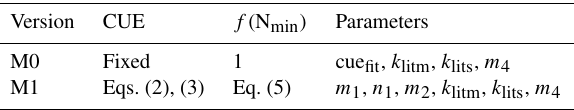
Table A3. List of parameters calibrated for two versions of the litter decomposition model (M0, M1): k litm and k lits are, respectively, the turnover rates of metabolic and structural litter pools, m 4 is the coefficient in Eq. (8), cue fit is the optimized value of CUE, m 1 and n 1 are the coefficients in Eq. (3), and m 2 is the coefficient in Eq. (5).